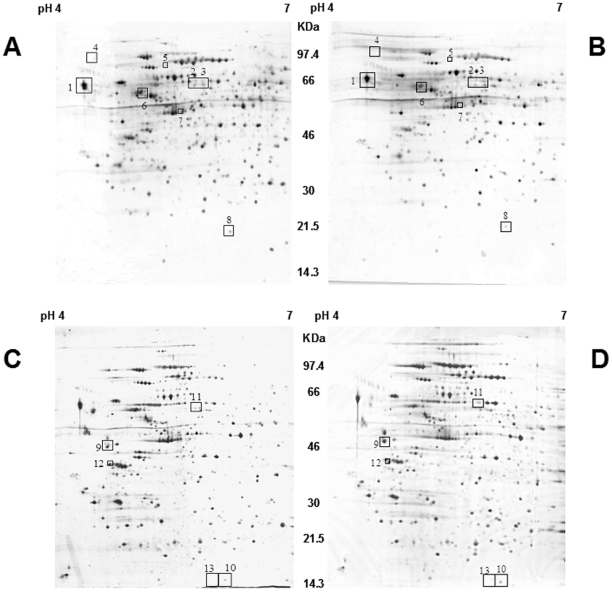
2-DE analysis of NB cells treated or not with ATRA.Representative image from three independent experiments of coomassie-stained 2-DE patterns of NB cell line SJ-N-KP: (A) 24 h control cells; (B) 24 h ATRA treatment; (C) 9 days control cells; (D) 9 days ATRA treatment. Proteins were separated using 17-cm, pH-4–7 strips followed by SDSPAGE on 10%, 18×20-cm gels. Proteins showing apparent differential expression were identified by progressive numbers on the black squares. Corresponding identifications are reported in Table 1 and 2.